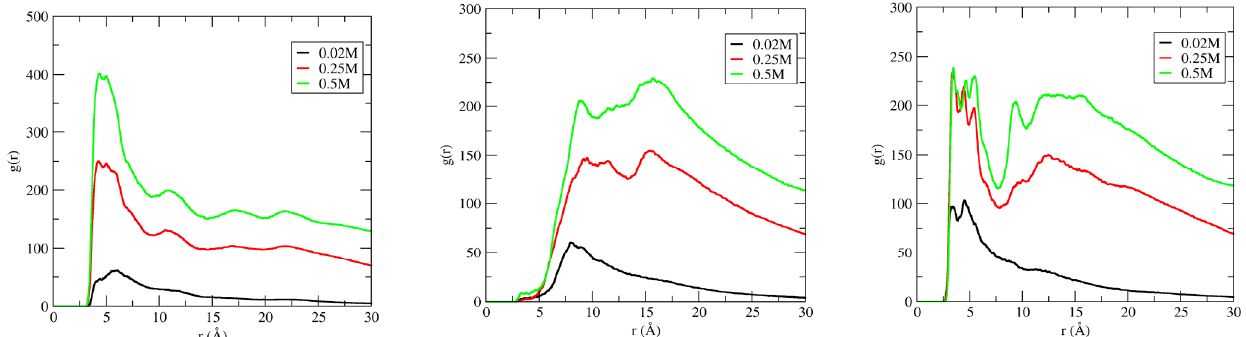
Figure 9. Concentration dependence of the [Im 16,1 ] + imidazolium ring center-of-mass distribution functions around the phosphate backbone ( left panel ), major groove ( middle panel ), and minor groove ( right panel ) of DNA duplex in aqueous solutions. IL concentrations are 20 mM (black line), 250 mM (red line), and 500 mM (green line) in each panel.